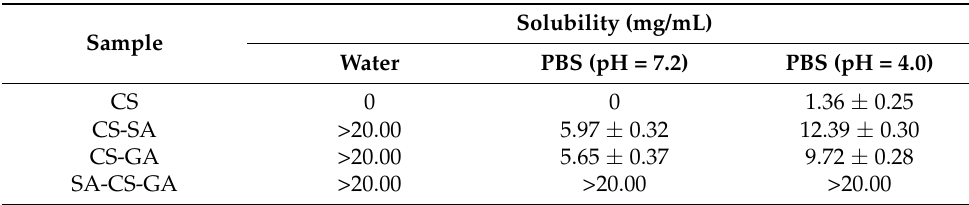
Table 1. Solubility of novel chitosan derivatives. Data are presented as mean ± SD of three inde- pendent experiments.